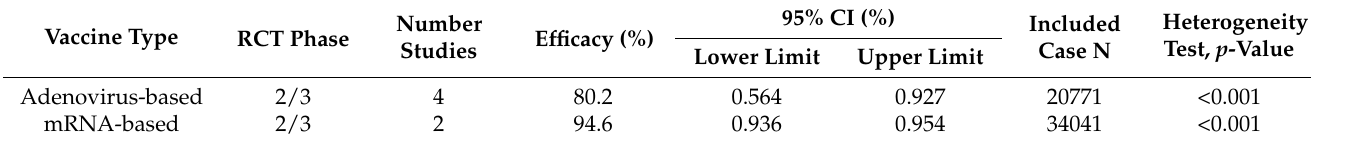
Table 2. Efficacy of adenovirus-based and mRNA-based COVID-19